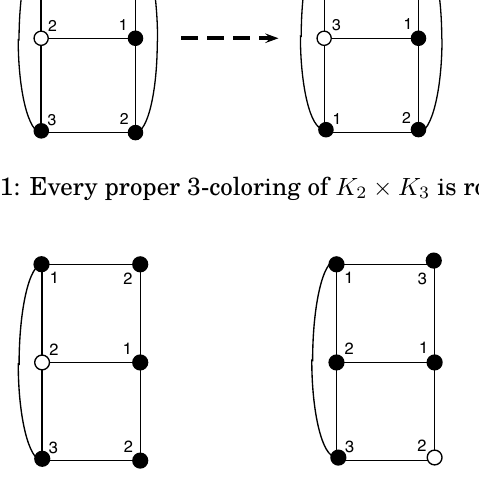
Figure 2: The two proper 3-colorings of a subgraph of K 2 × K 3 . In each, the white vertex is not locally